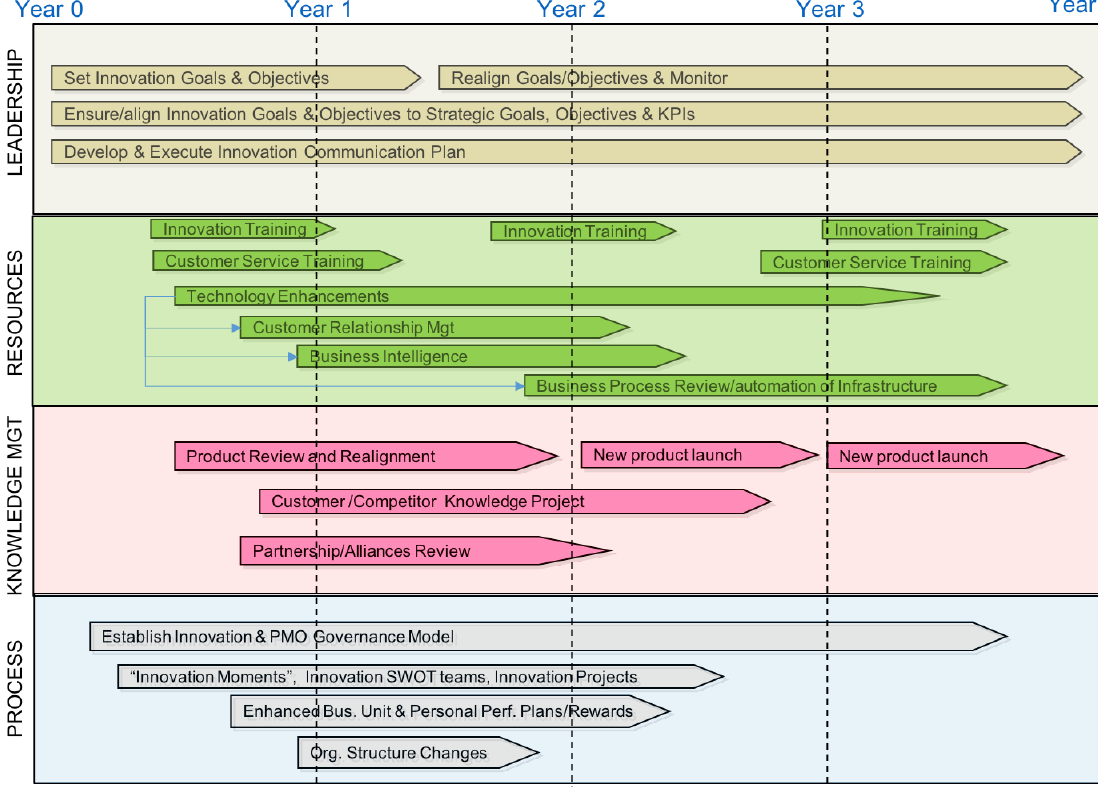
Fig. 5. FinanCo Innovation Implementation